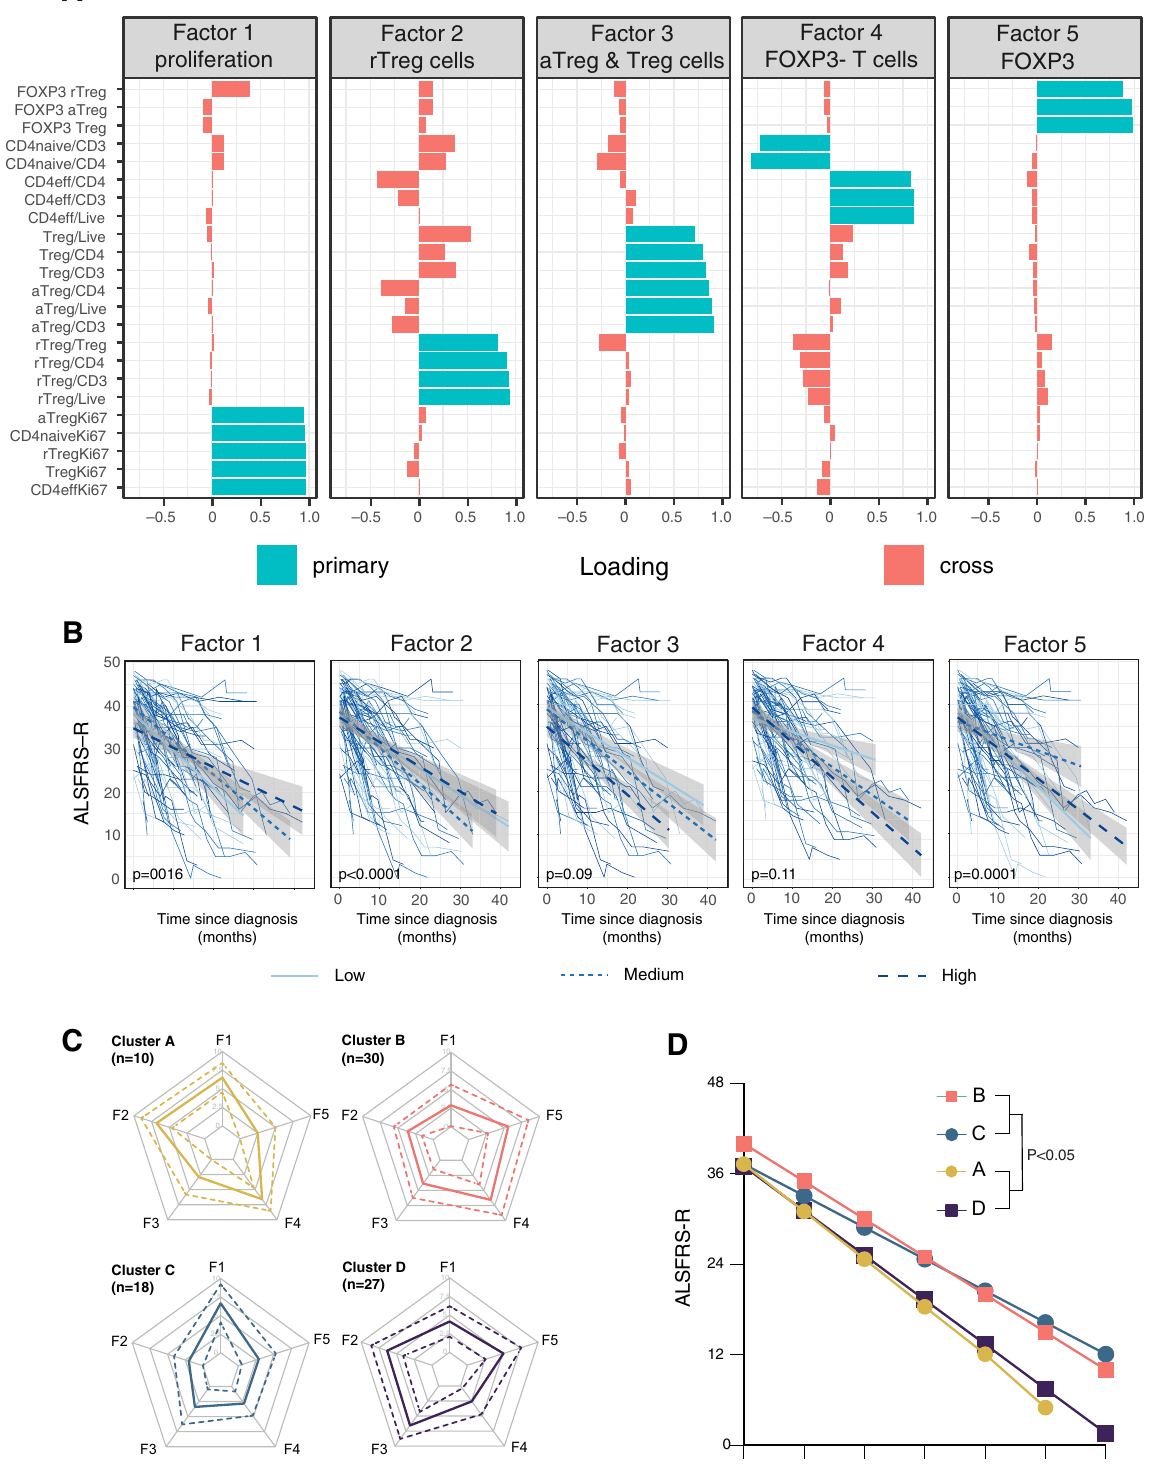
Fig. 2 | Distinct T cell pro fi les are associated with differential ALS disease progression. Exploratory factor analysis was used to reduce the fl ow cytometric dataintosummaryvariablesandresultedin fi vefactorsthatexplained89.5%ofthe totalvariance( A ). ALSpatientswerestrati fi ed by thefactors.Longitudinalchanges in the ALS functional rating scale-revised (ALSFRS-R) in blood were analysed using linear mixed models with mean and 95% con fi dence intervals for each category of